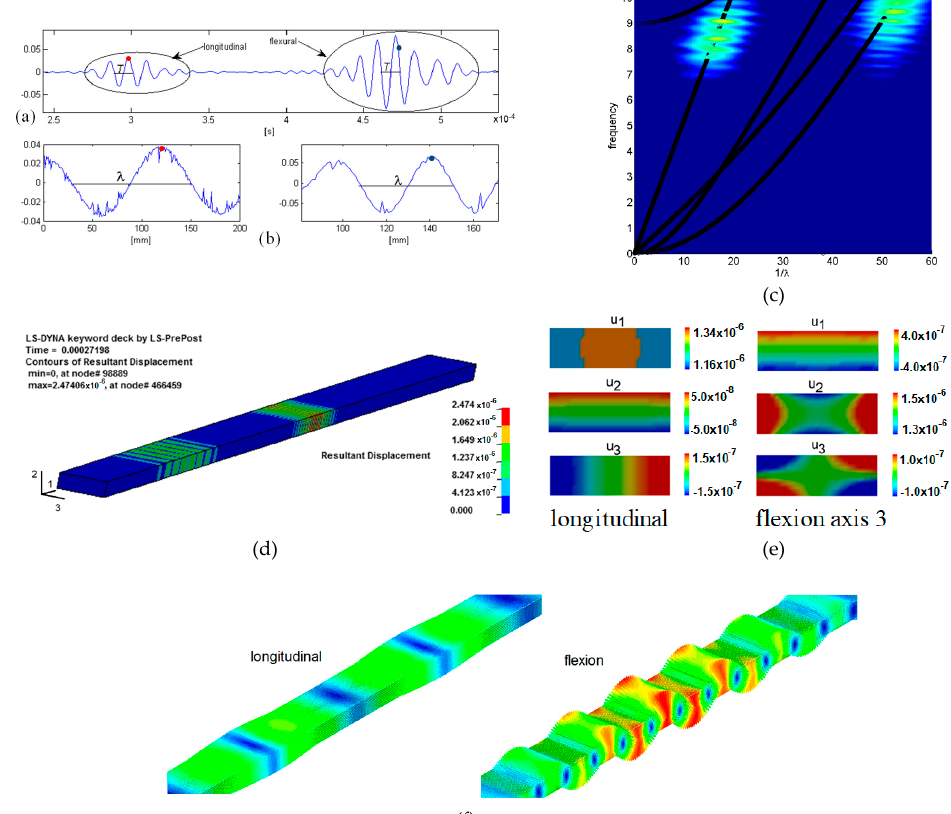
Figure 10. A tone burst with the main frequency of 80 KHz in longitudinal direction. Experimental results: ( a ) displacements measured in a point over the scan line where T is the period of each wave propagation mode. ( b ) Displacements over the scan line at a specific time. Numerical results: ( c ) amplitude displacement in the frequency vs. wave number dominium (with a black line indicating the dispersion curves). ( d ) Bar analyzed with the map of displacement on it, at a specific time. ( e ) Transversal section with the spatial distribution of two wave modes. ( f ) Tridimensional mode views. The circle dots in Figure 12 indicate the pairs f and k = 1 / λ found in each test performed. Only one test of each configuration was conducted. However, despite this limitation in the experimental verification, a good agreement between the experimental and numerical dispersion curves performed with SAFE [28] method is presented in the same figure. The highest distortions are founded in the bending